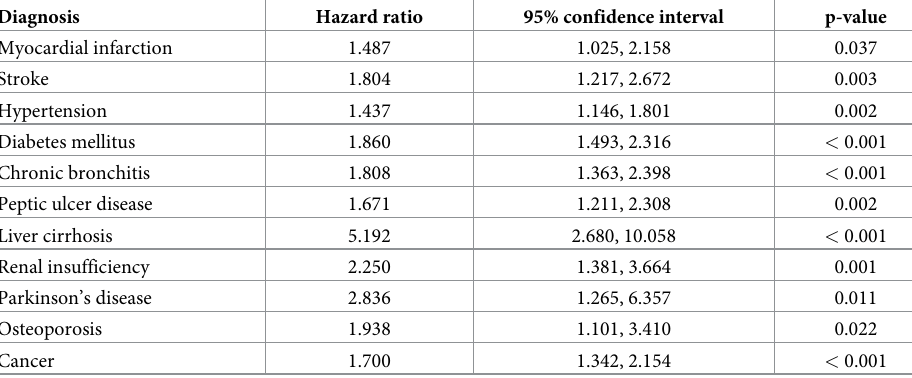
renal insufficiency, Parkinson’s disease, osteoporosis and cancer. For details on the relations of these diagnoses see Table 4. Multivariate analysis: Cox regression model for all reported comorbidities adjusted for age, sex, BMI and smoking status In multivariate analysis adjusted for age, sex, BMI and smoking status, hypertension, diabetes mellitus, asthma, chronic bronchitis, peptic ulcer disease, Parkinson’s disease, osteoporosis and cancer were significantly associated with the survival time (Table 5). Tuberculosis was not significantly but relevantly associated with survival, with p-value less than 10%. Optimal model: Cox regression model for all signifffikant and relevant comorbidities adjusted for age, sex, BMI and smoking status were included in this model Based on consistency with clinical observations and a method of D. Collet [1], we submitted a selection of factors of the previous multivariate analysis to a subsequent multivariate analysis adjusted for age, sex, BMI > 25, and smoking status. Table 5. Relation between single diagnoses and survival time for diagnoses with significant relations according to multivariate analysis. Diagnosis Hazard ratio 95% confidence interval p-value p-value < 0.05 (significantly associated): Hypertension 1.500 1.139, 1.976 0.004 Diabetes mellitus 1.452 0.512 2.337 Peptic ulcer disease